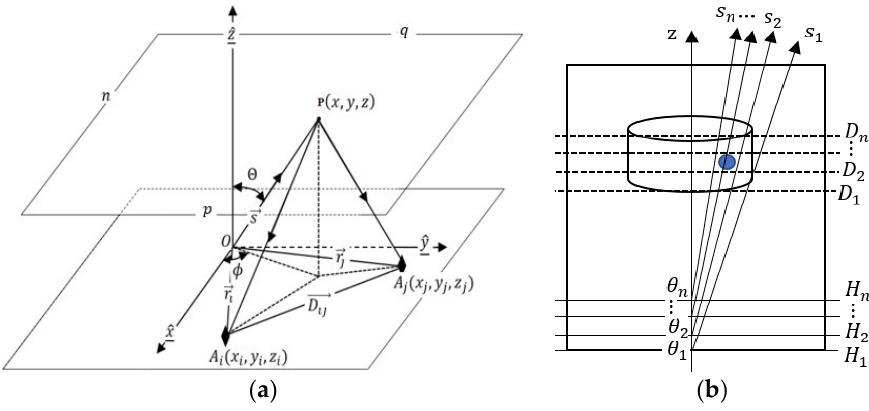
Figure 2. ( a ) A sensor-pair; ( b ) 3D view of sensor array plane.